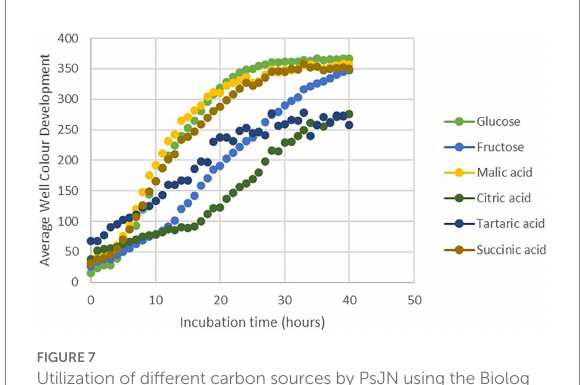
FIGURE 7 Utilization of different carbon sources by PsJN using the Biolog (PM1 and PM2) microplate method.